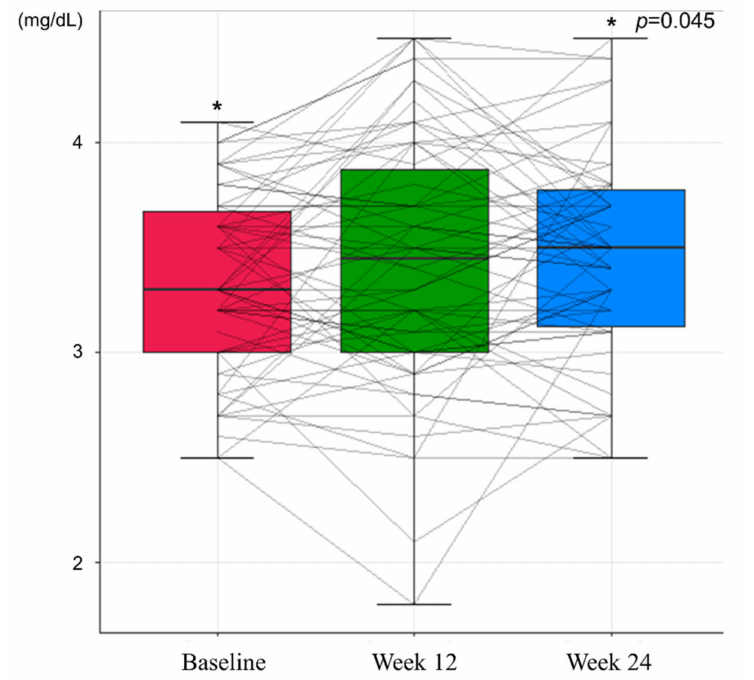
Figure 4. Changes in serum phosphorus levels during the study period (* p